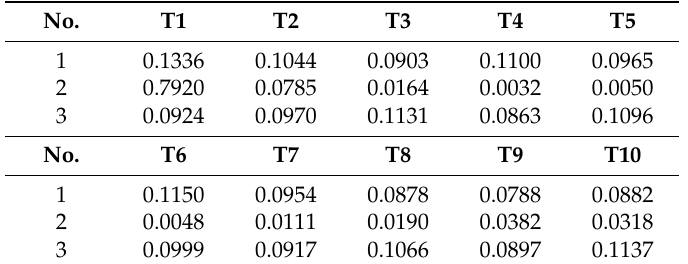
Table 6. Texting sample data for load identification in BP neural network (sinusoidal